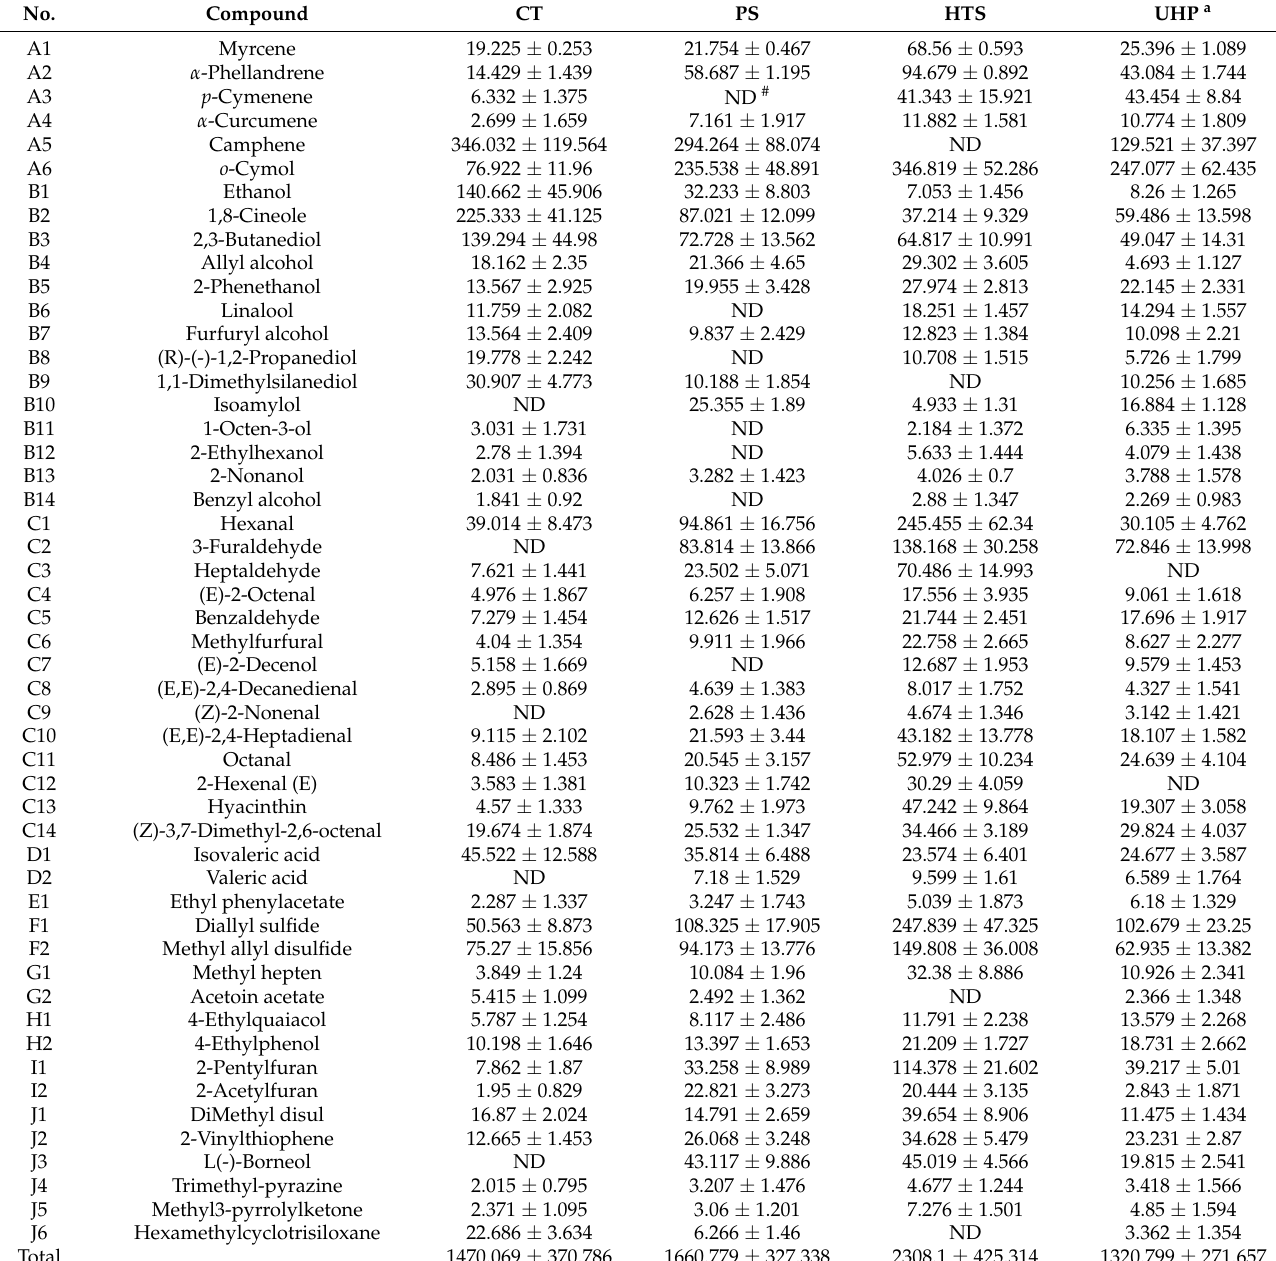
Table 1. Concentration ( µ g/kg) of volatile compounds in the sauce after